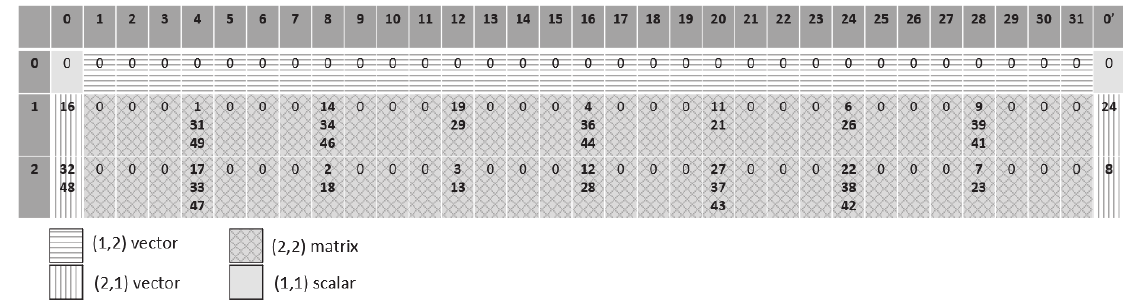
Figure 7. FFT of Finite ‐ Element torque for the five ‐ phase IM with 64 bars. Under sequence “u = 1” ( θ ) for the five-phase IM with 64 bars (in each line, Figure 8. Space harmonics distribution in L sr (cid:4666)θ(cid:4667) for the five ‐ phase IM with 64 bars (in each line, 7 (the planes of line (1), Figure 9 are excited). Figure 9. Space harmonics distribution in L (cid:2929)(cid:2928) αβ (cid:3209)(cid:3210) 7 rotor planes, among 31, and both zero-sequences are excited, which lead to harmful interactions). rotor planes, among 31, and both zero ‐ sequences are excited, which lead to harmful interactions).